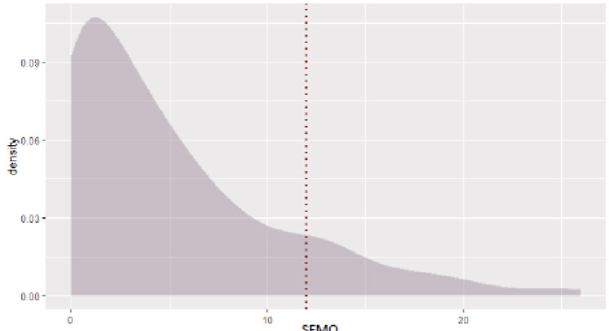
Figure 1. Distribution of SMFQ Scores on total population.